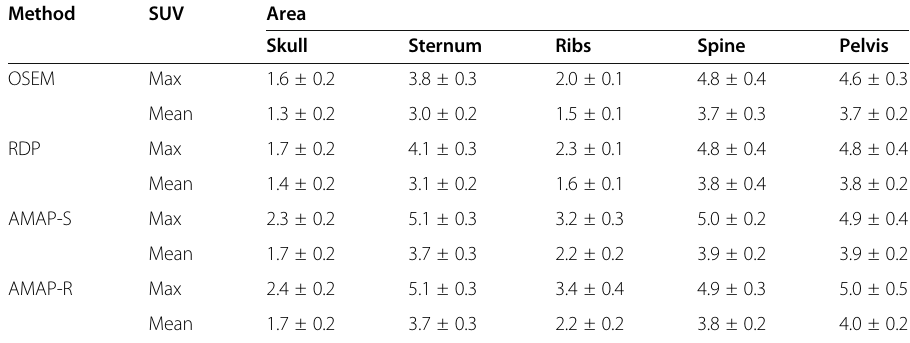
Table 6 Normal uptake SUV max and SUV mean (mean ± standard deviation) for the clinical